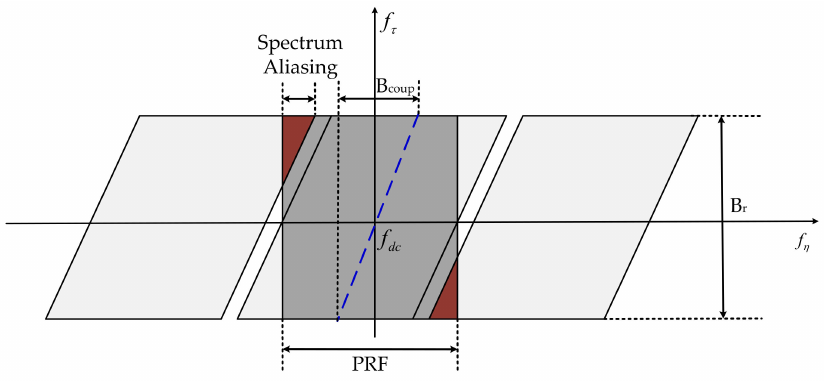
Figure 10. 2-D spectrum of HEO SAR signal in squint